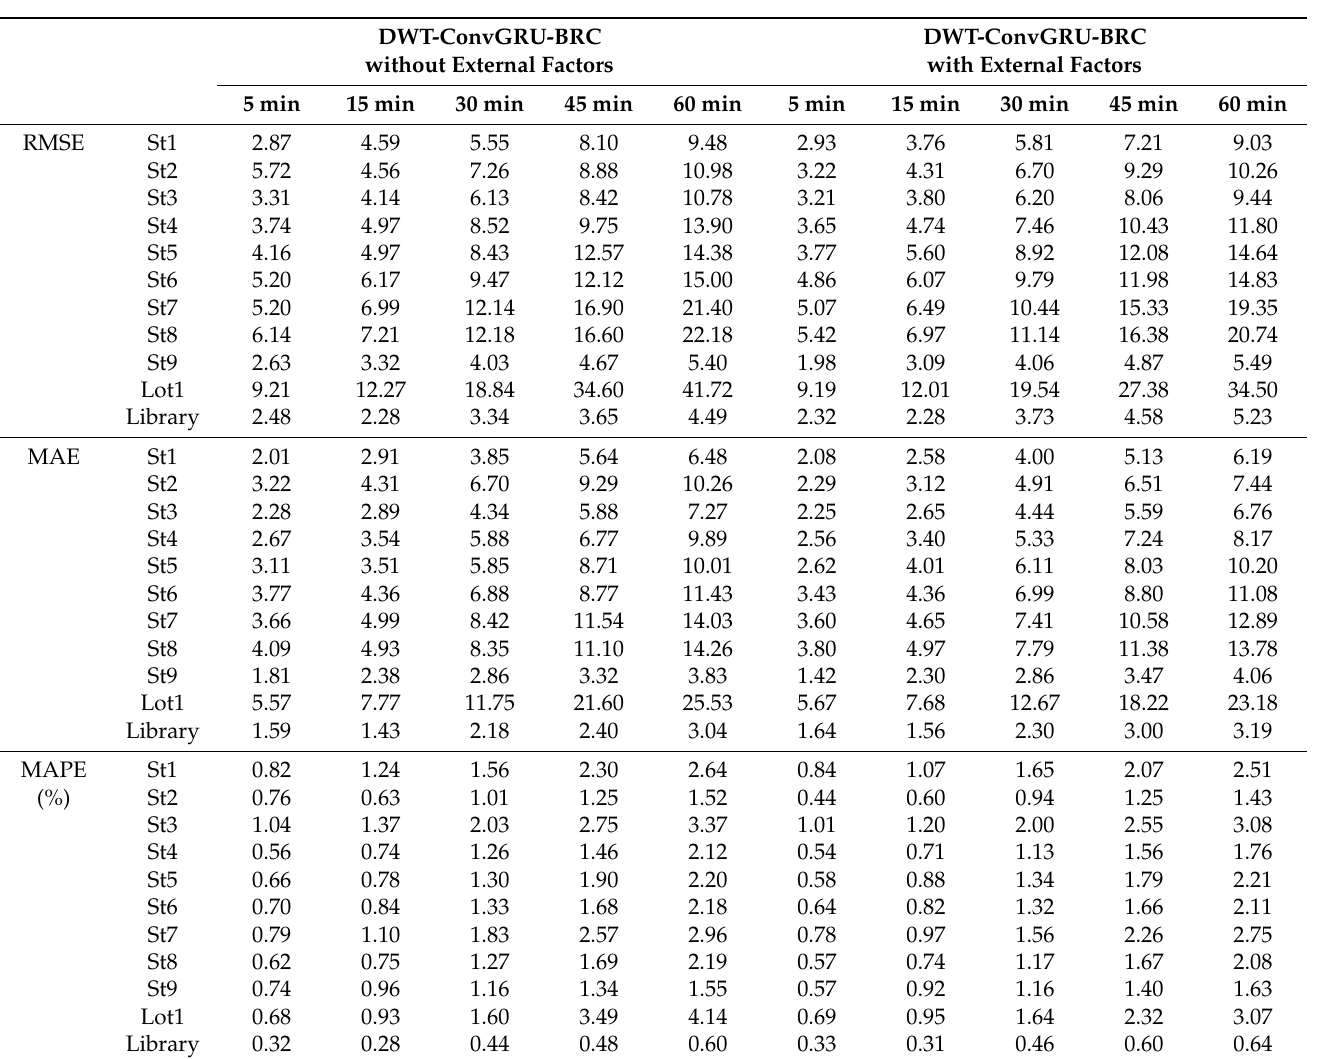
Table 1. Performance evaluation in terms of the MAE, RMSE, and